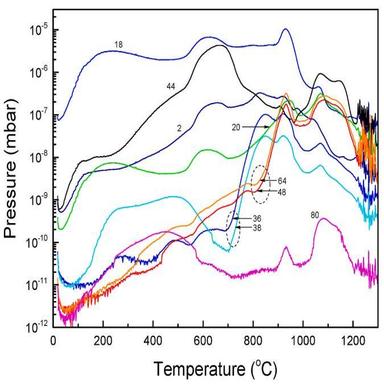
Selected traces from the mass spectra, identified by the m/z numerical labels, as a function of temperature. These are used to identify H2 (2), H2O (18), CO2 (44), SO2 (48,64), SO3 (80), as well as HF (20), HCl (36,38) at higher temperatures.